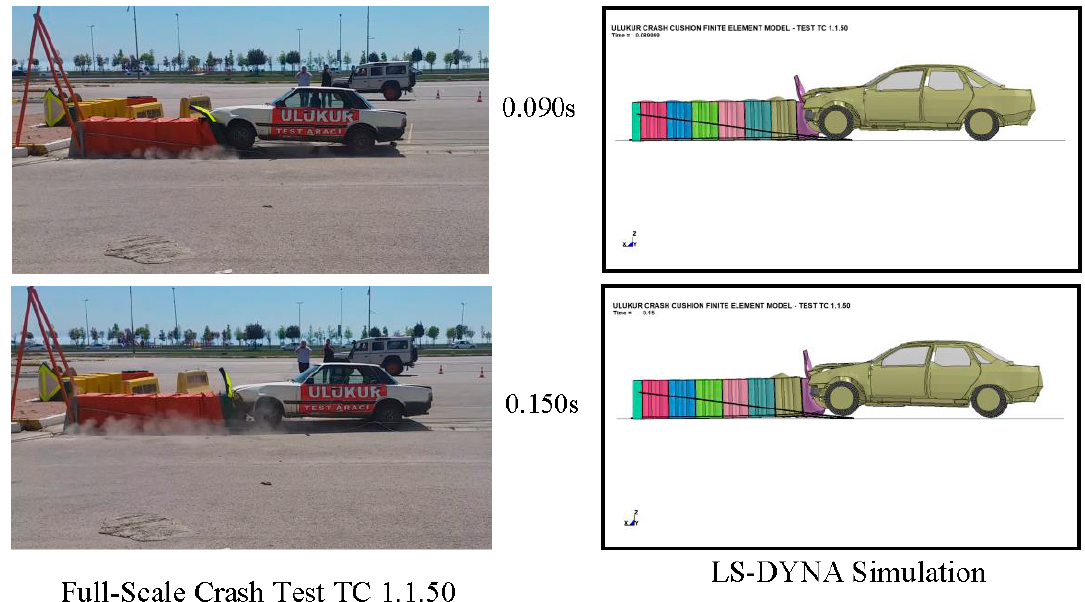
Figure 7. Sequential picture comparison of UCC after TC 1.1.50 crash test and simulation.